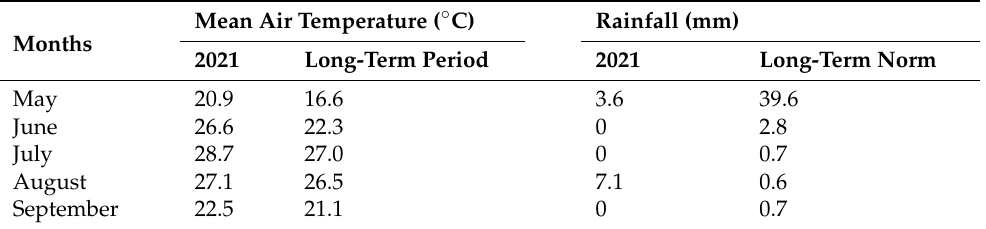
Table 1. Mean air temperature and rainfall during the growing season of 2021 and long-term period.